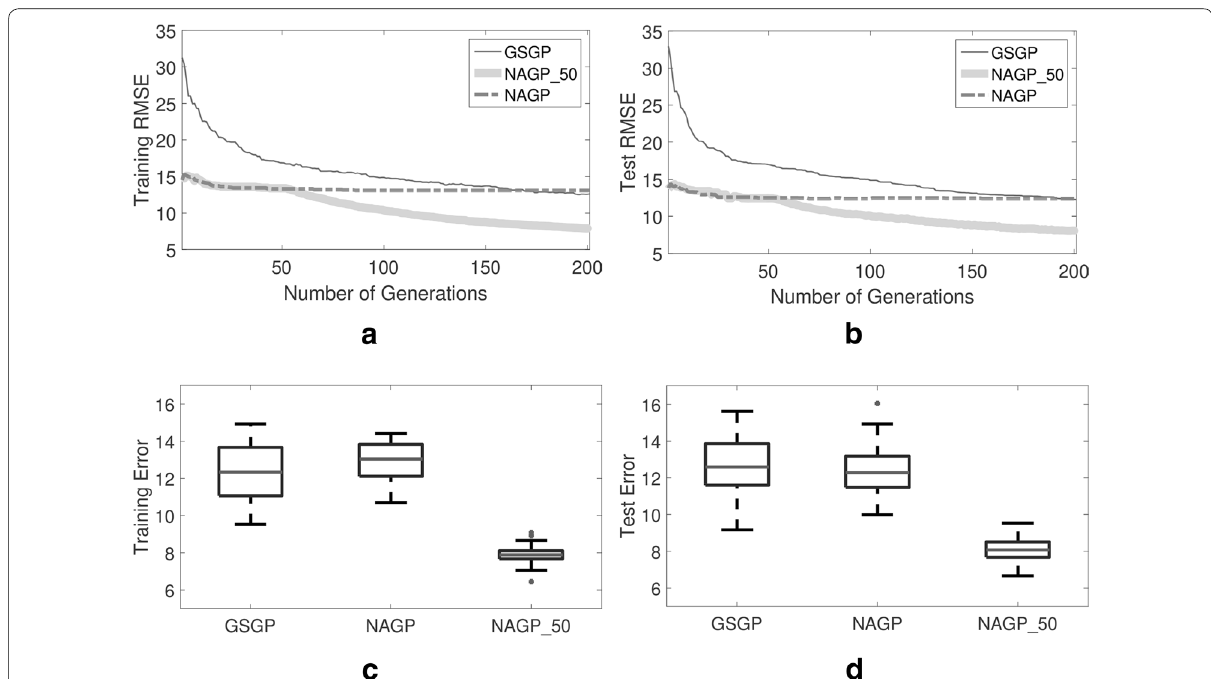
Fig. 7 Results of the error for the three studied methods. a Evolution of training error; b evolution of test error; c boxplots of the training error at the end of the run; d boxplots of the test error at the end of the run. All results are medians over 30 independent runs.